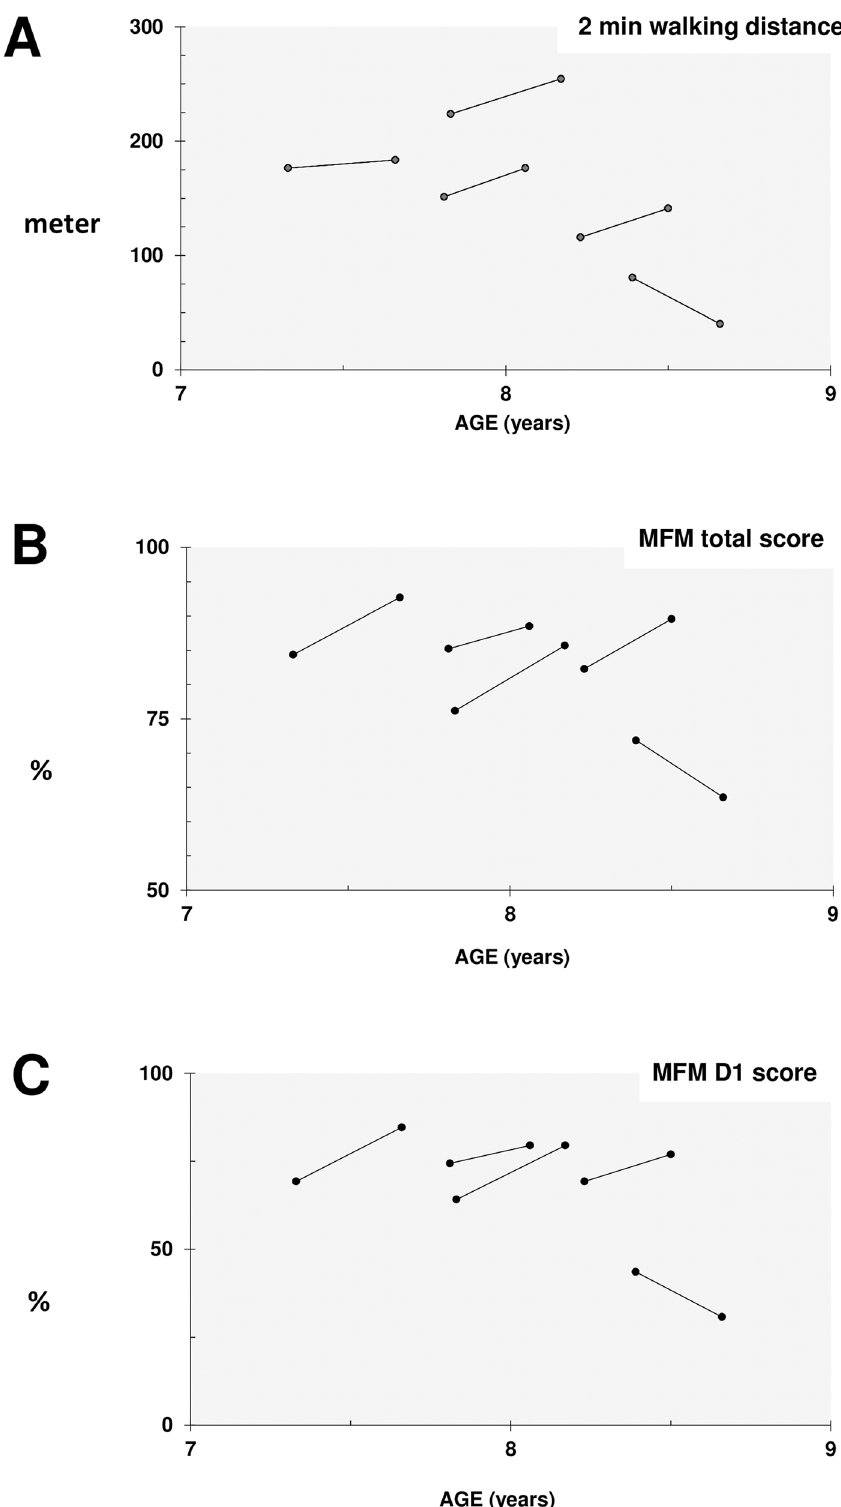
Fig 4. Clinical changes. Clinical changes over treatment period of 16 weeks are shown. Four of the five patients showed improvements in 2 min walking distance (A), the MFM total score (B) and the MFM D1 subscore